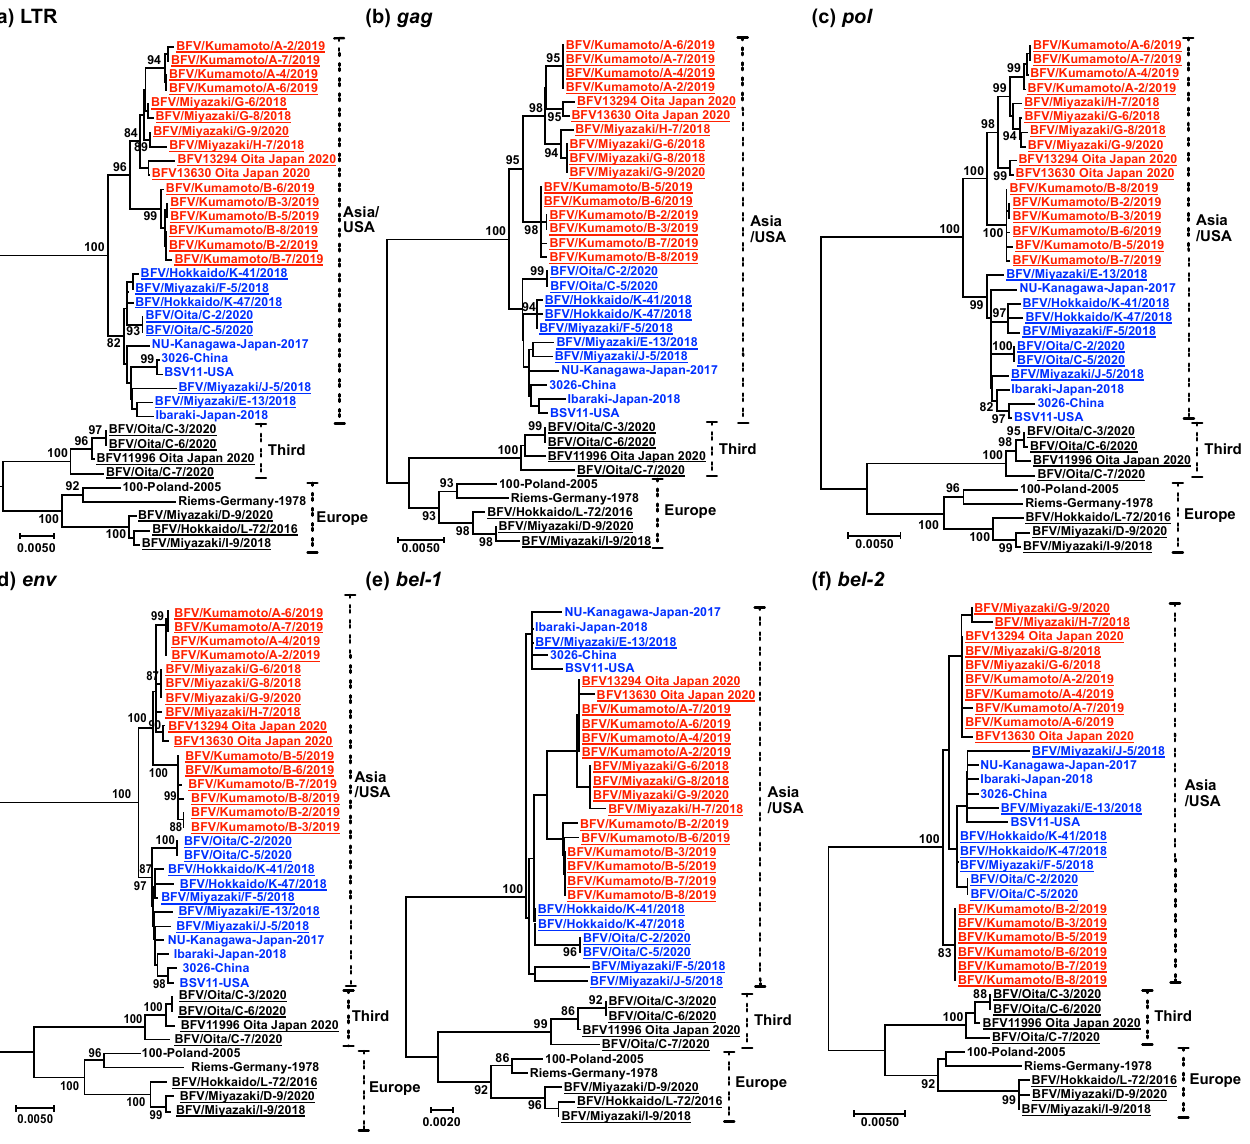
Figure 4. Phylogenetic analyses of the entire coding and noncoding genes of bovine foamy virus (BFV). Phylogenetic trees based on the entire LTR ( a ) and gag ( b ), pol ( c ), env ( d ), bel-1 ( e ), and bel-2 ( f ) genes. The 27 isolates for which the whole